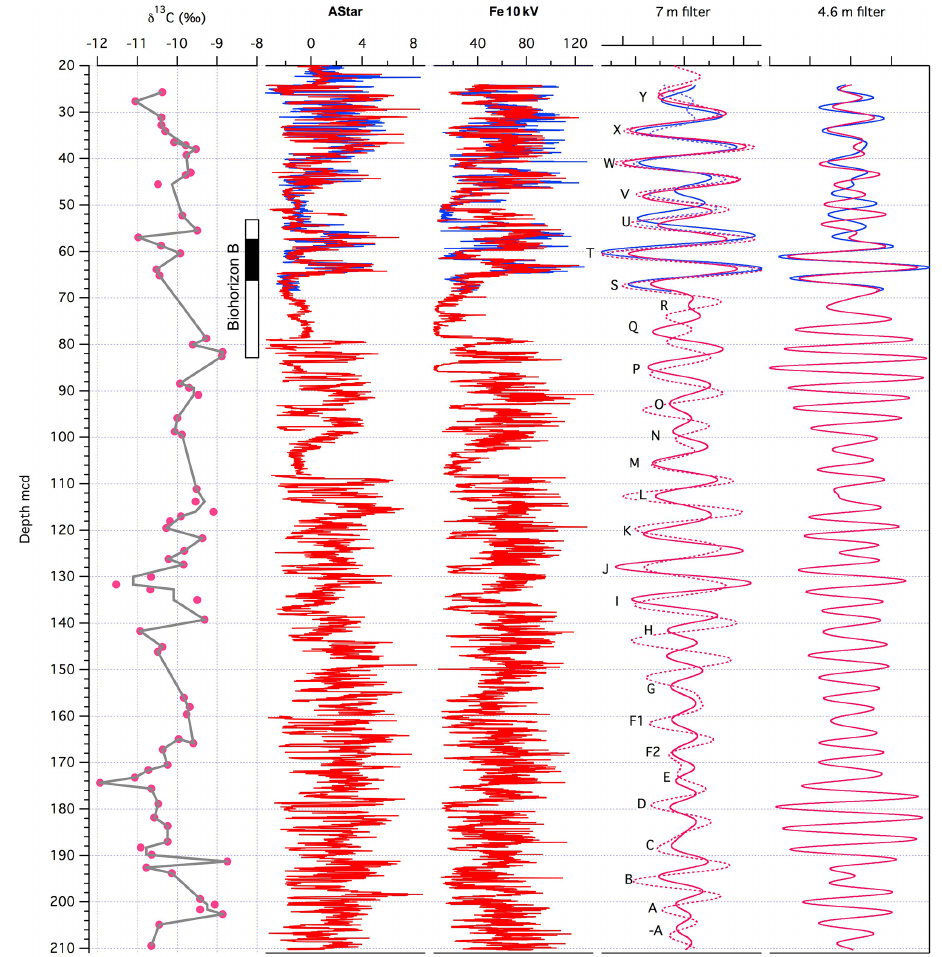
Figure 6. Cyclostratigraphy for Gilmore Hill. Left to right: GMH-A (red) soil nodule carbon isotope data (Table S9) for stratigraphic reference, a ∗ data from color scanning, and XRF Fe intensity data (in total counts area · 1000). The Gaussian filter of the longer 7m cycle (precession) of the Fe data (lines) and from a ∗ data (dashed lines). Letters mark the precession cycle counting following Abels et al. (2013) labeling at Deer Creek amphitheater. On the right is a Gaussian filter of the 4.6m cycle. Please note that the cyclostratigraphy is straightforward and correlates well with Abels et al. (2013) for the range A to P; however, cycles P to Y are new and not in Abels et al.